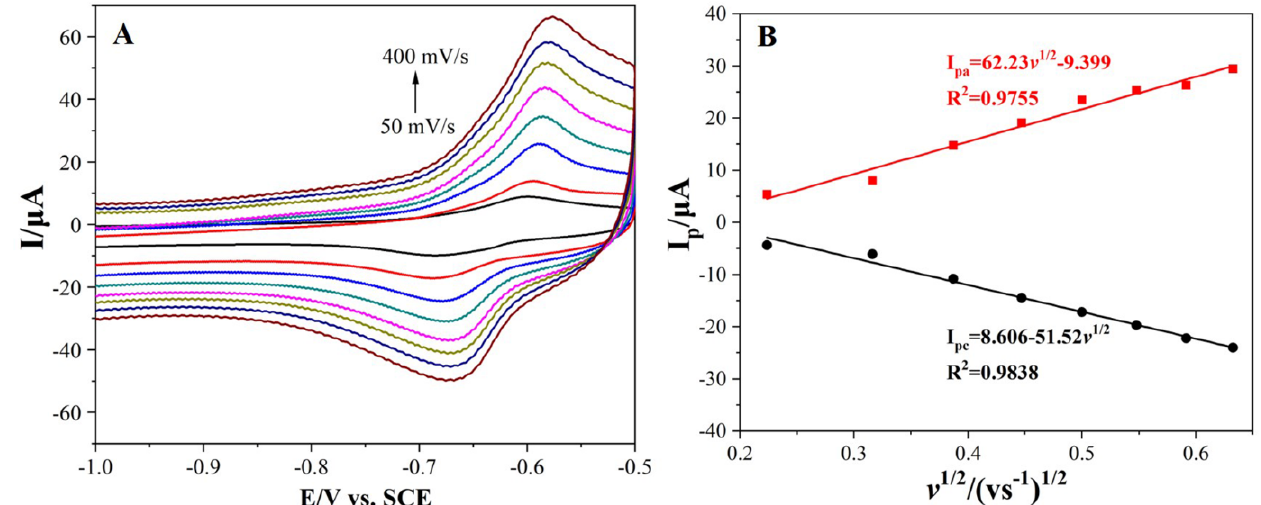
Figure 7. ( A ) The CV curves of Pb 2+ recorded at various scanning rates in 10 mL of 0.1 M HAc-NaAc buffer (pH = 5.5) containing 1.0 μ M of Pb 2+ . ( B ) A linear plot of I pa (Pb 2+ ) versus square root of scanning rate ( v 1/2 ).